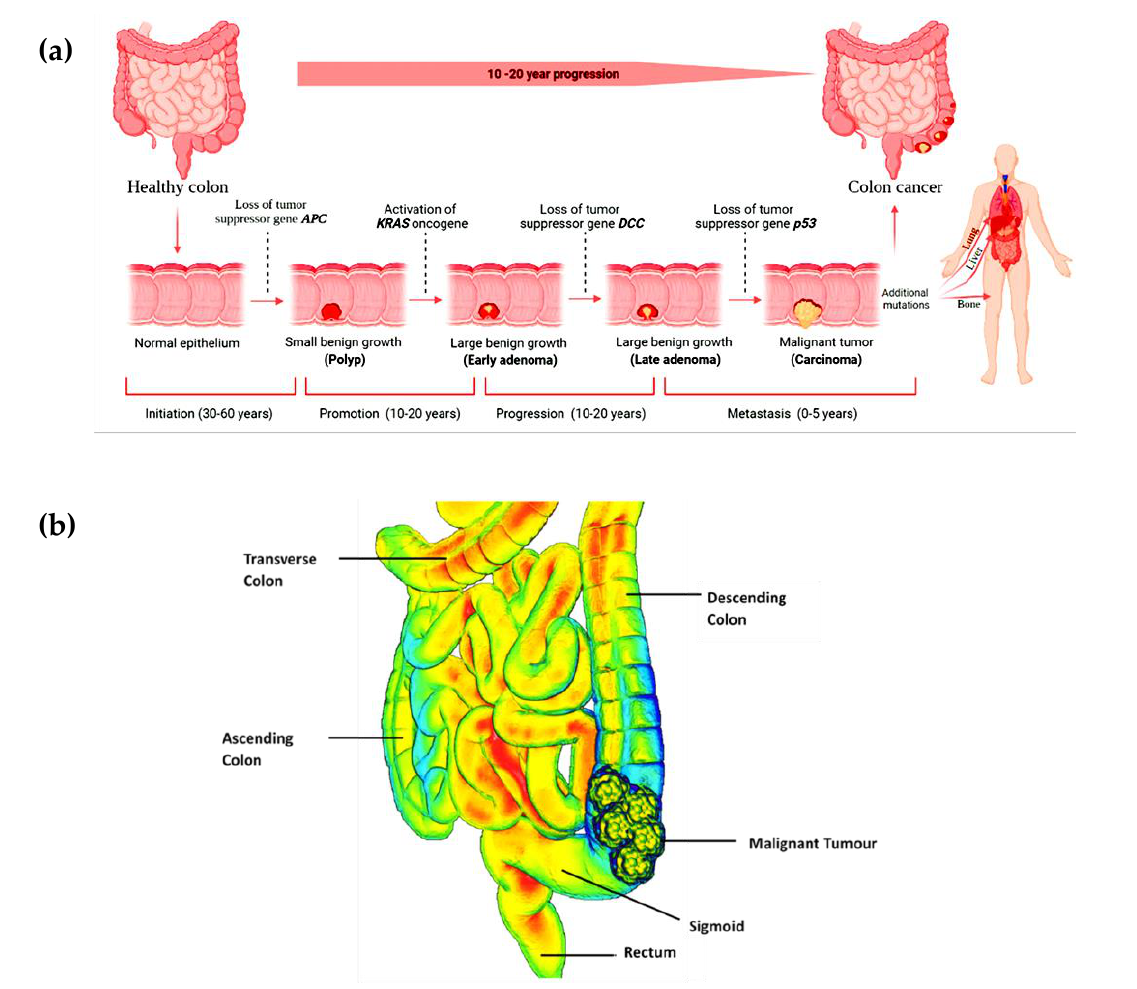
Figure 1. Schematic illustration showing ( a ) different stages of colon cancer, [6] reproduced with permission from MDPI and ( b ) different parts of colon with malignant tumour.